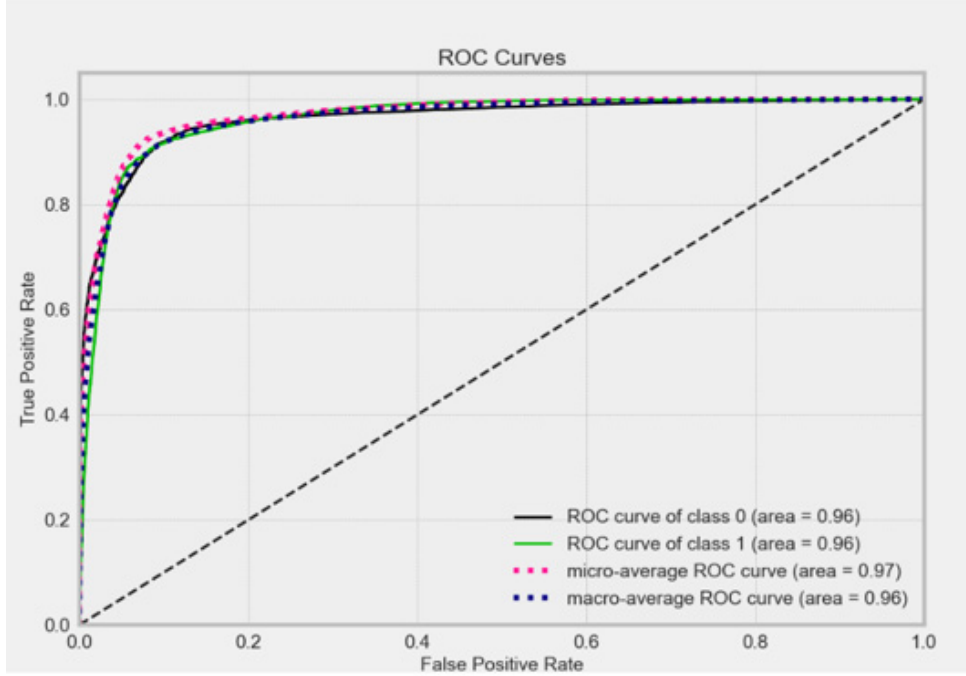
Figure 22. ROC Curves for Catboost models.